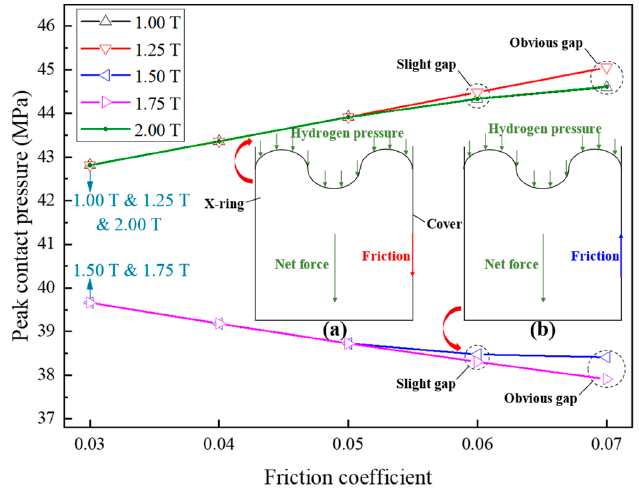
Figure 9. Relationship between peak contact pressure and C f during 1–2 T. ( a ) Schematic diagram of the forces on the X-ring during 1–1.25 T and 1.75–2 T; ( b ) Schematic diagram of the forces on the X-ring during 1.25–1.75 T.